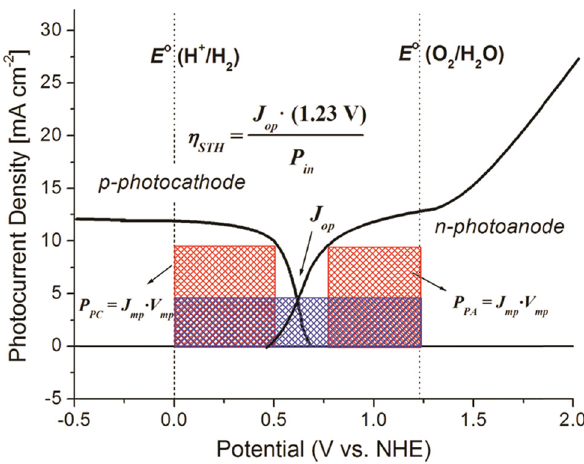
Figure 6: Overlaid current density – potential ( J – V ) behavior for a p - type photocathode and an n - type photoanode, with overall e ffi - ciency generated by the cell for splitting water. Reprinted with permission from ref. [ 18 ] . ©2010 American Chemical Society ( ACS )